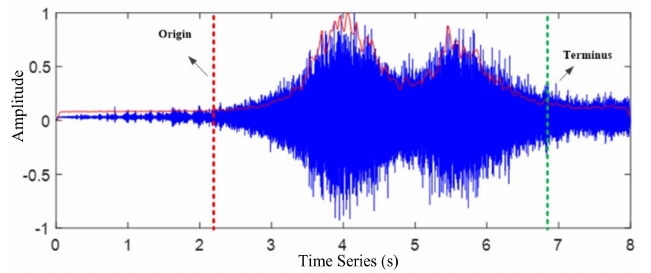
Figure 1. Traffic noise signal